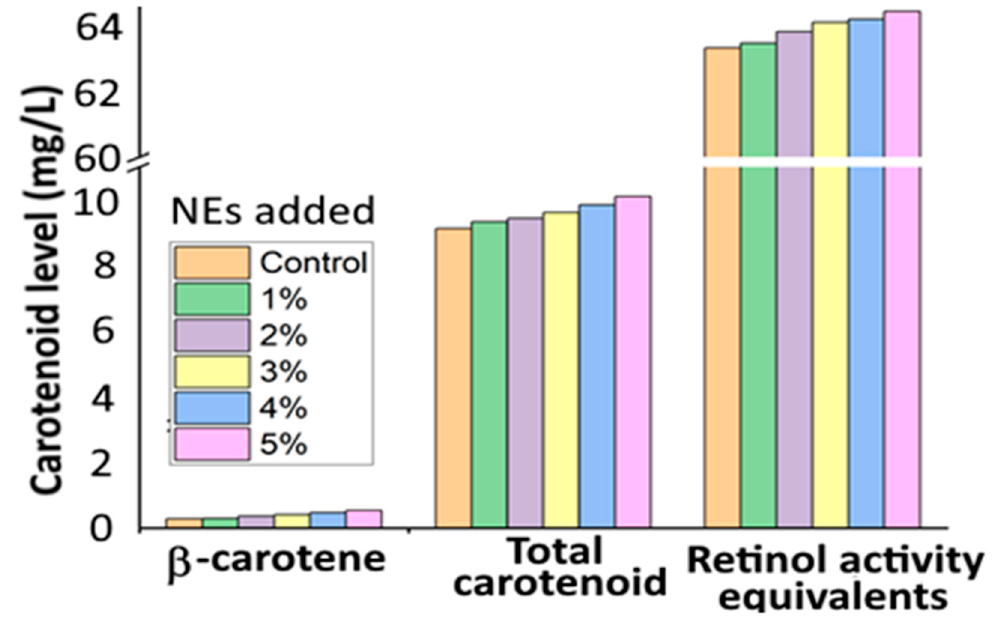
Figure 5. Levels of β -carotene, total carotenoid and retinol activity equivalents in the gastric and pancreatic digests for different levels of carotenoid nanoemulsions (1–5%) prepared from orange peel waste extract. The results were expressed as mean ± standard deviation of ≥ 3 independent replicates. NEs = nanoemulsions. Adapted with permission from Barman, et al. [33].